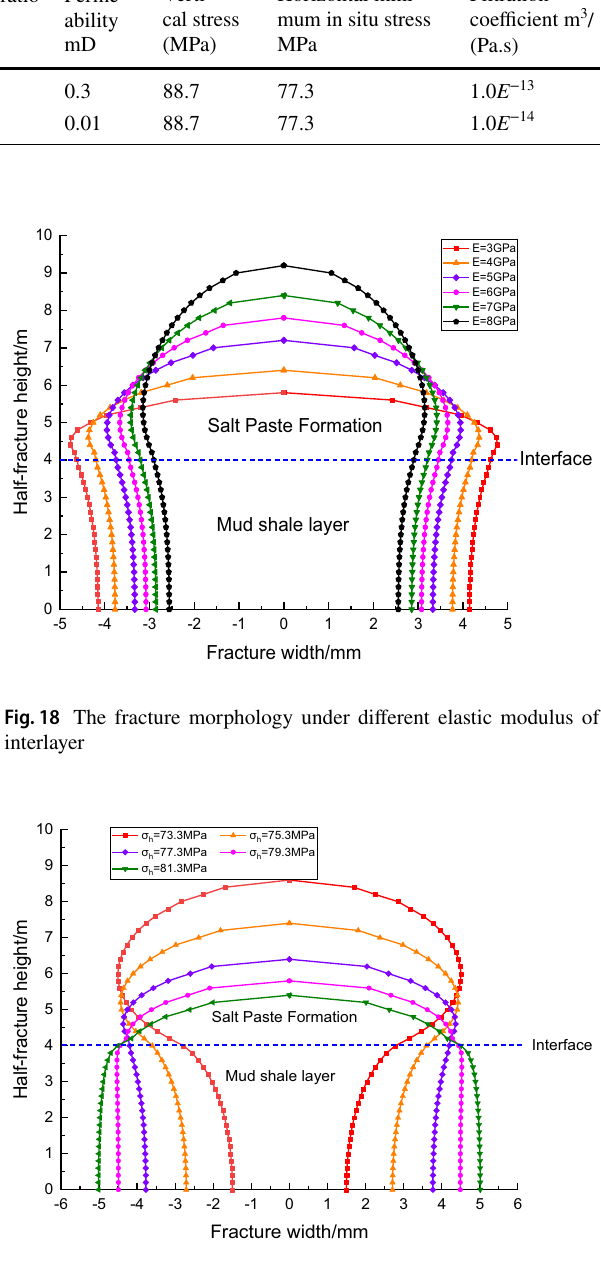
Fig. 19 The fracture morphology under different minimum horizontal in situ